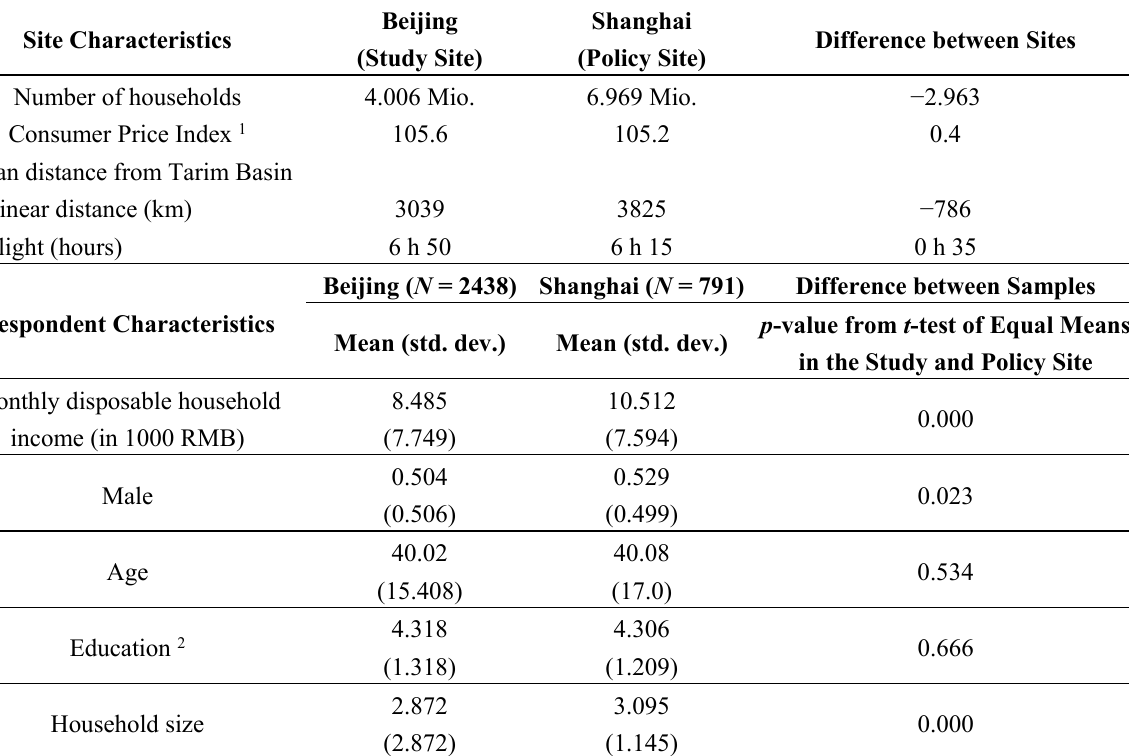
Table 3. Characteristics of the population at the study and policy